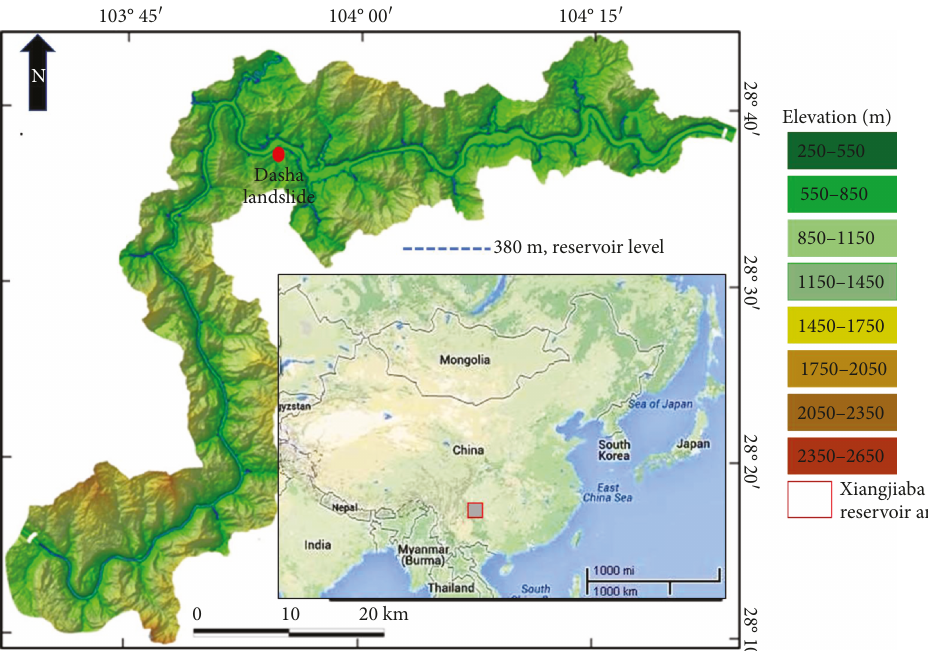
Figure 1: Topography of the reservoir